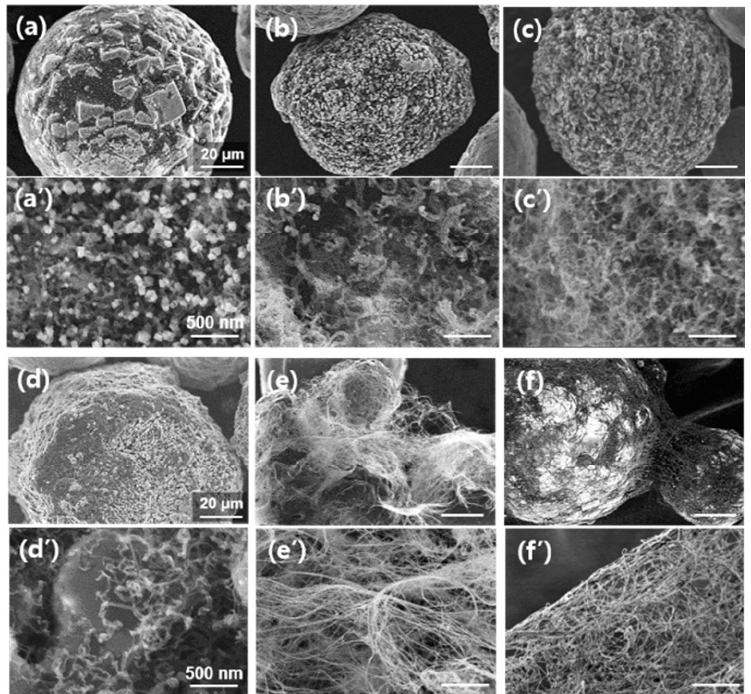
Figure 3. Low and high-magnification of SEM images showing CNTs directly grown on Al 2 O 3 particles using RCVD system. Growth temperatures are ( a , a’ ) 600, ( b , b’ ) 650, ( c , c’ ) 700, ( d , d’ ) 750, ( e , e’ ) 800, and ( f , f’ ) 825 ◦ C, respectively. Growth time and rotation speed are fixed at 10 min and 10 rpm, respectively. To investigate the change in the quality of the produced CNTs (including the crystal